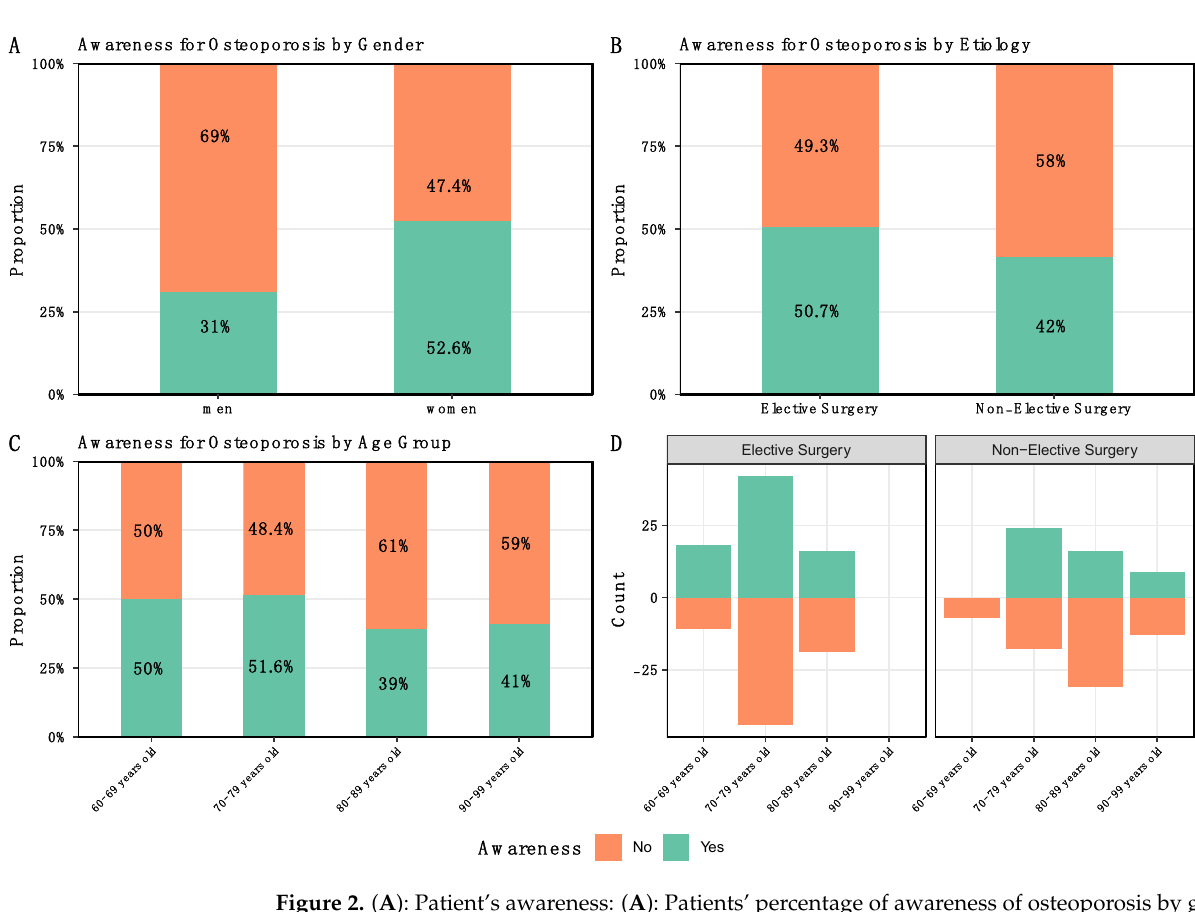
Figure 2. ( A ): Patient’s awareness: ( A ): Patients’ percentage of awareness of osteoporosis by gender, shows an alarming lower awareness among men; ( B ): Patients’ awareness for osteoporosis divided by electivity in percent, among patients not affected by a fracture, a higher percentage has awareness; ( C ): Percentages of patients’ awareness of osteoporosis by age groups; Awareness is highest in the age group 60–69 years and lowest in the age group 80–89 years; ( D ): Patients’ awareness for osteoporosis divided by Electivity and age groups in percent. Only in the 70–79 age group is awareness higher among trauma patients than among elective patients. In the age group 90+ no elective patients could be included.